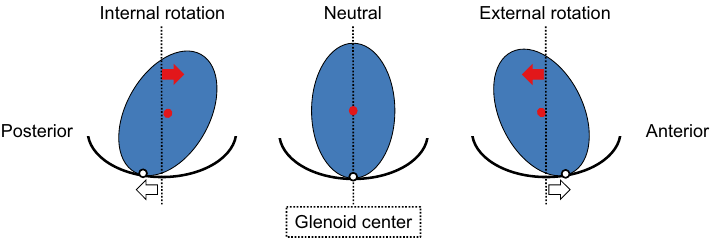
Figure 6. Influence of oblateness of humeral head on translation of the center of glenohumeral contact area (CGHCA; white dot) and the center of humeral head (CHH; red dot) during shoulder rotation in axial plane. At internal rotation position, CGHCA translated posterior (white arrow) whereas CHH translated anterior (red arrow). At external rotation position, CGHCA translated anterior (white arrow) whereas CHH translated posterior (red